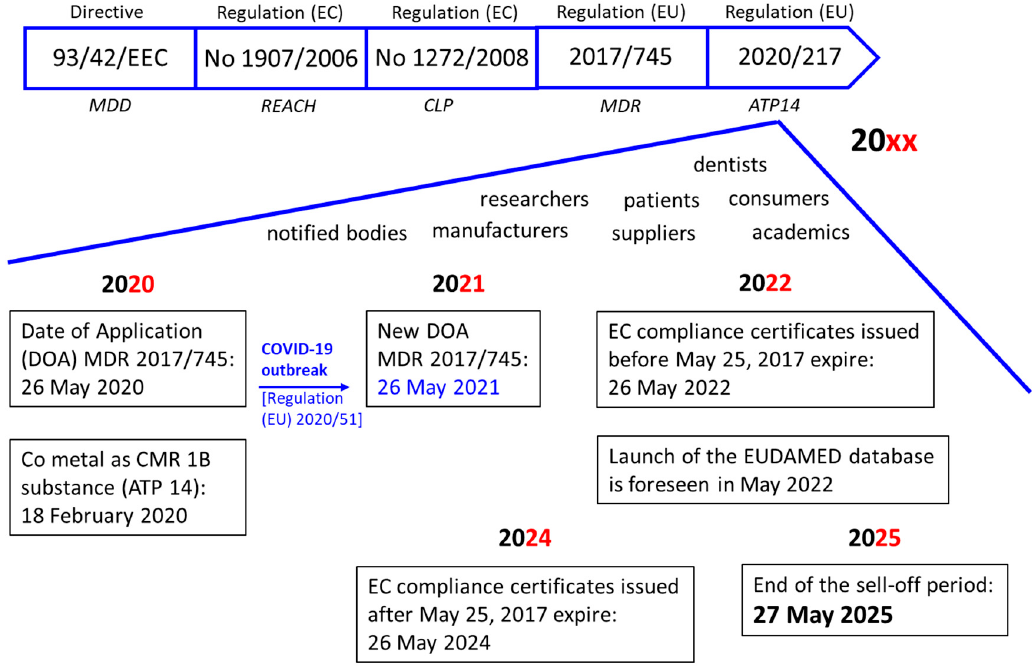
Figure 1. European Union (EU) medical device regulation timeline until 2020 and beyond.